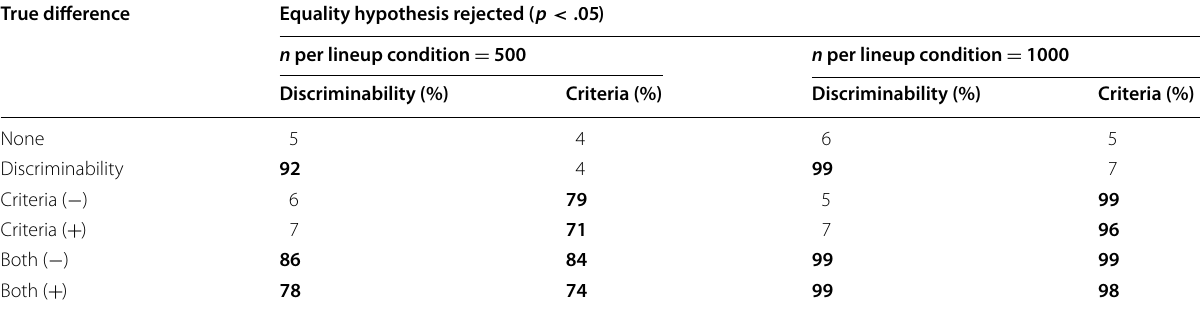
Two-hundred datasets were simulated per scenario. The percentages in bold denote the correct rejections. Symbols + and − in parentheses indicate whether the criteria in group B are more lenient or stricter, respectively